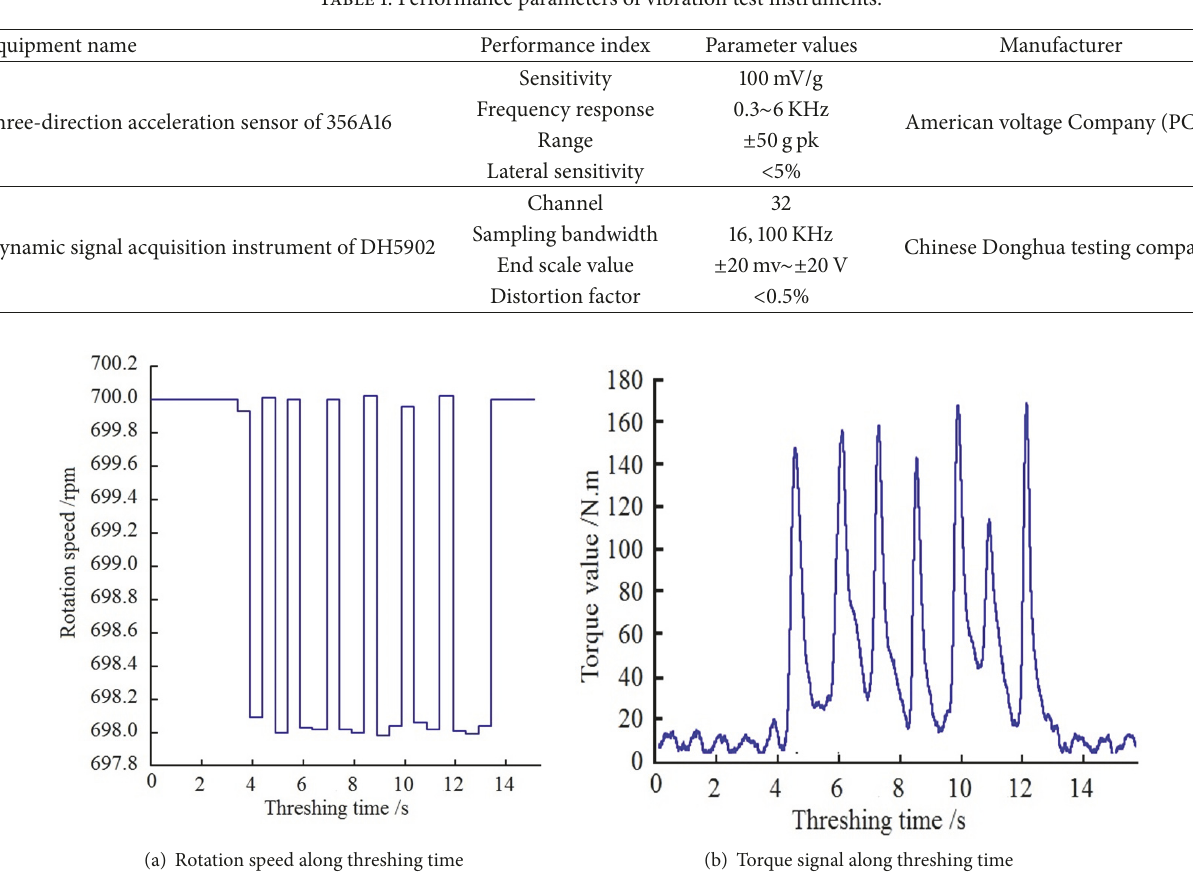
Figure 7: Curves of torque and speed state of tangential threshing cylinder during rice threshing